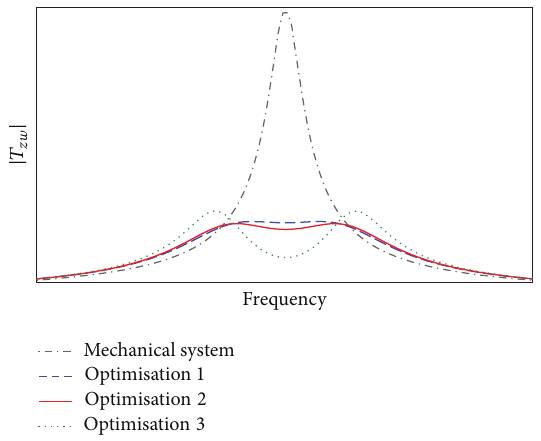
Figure 10: Example of the three optimization criteria for the electrical damping 𝜉 𝑝 for a generic